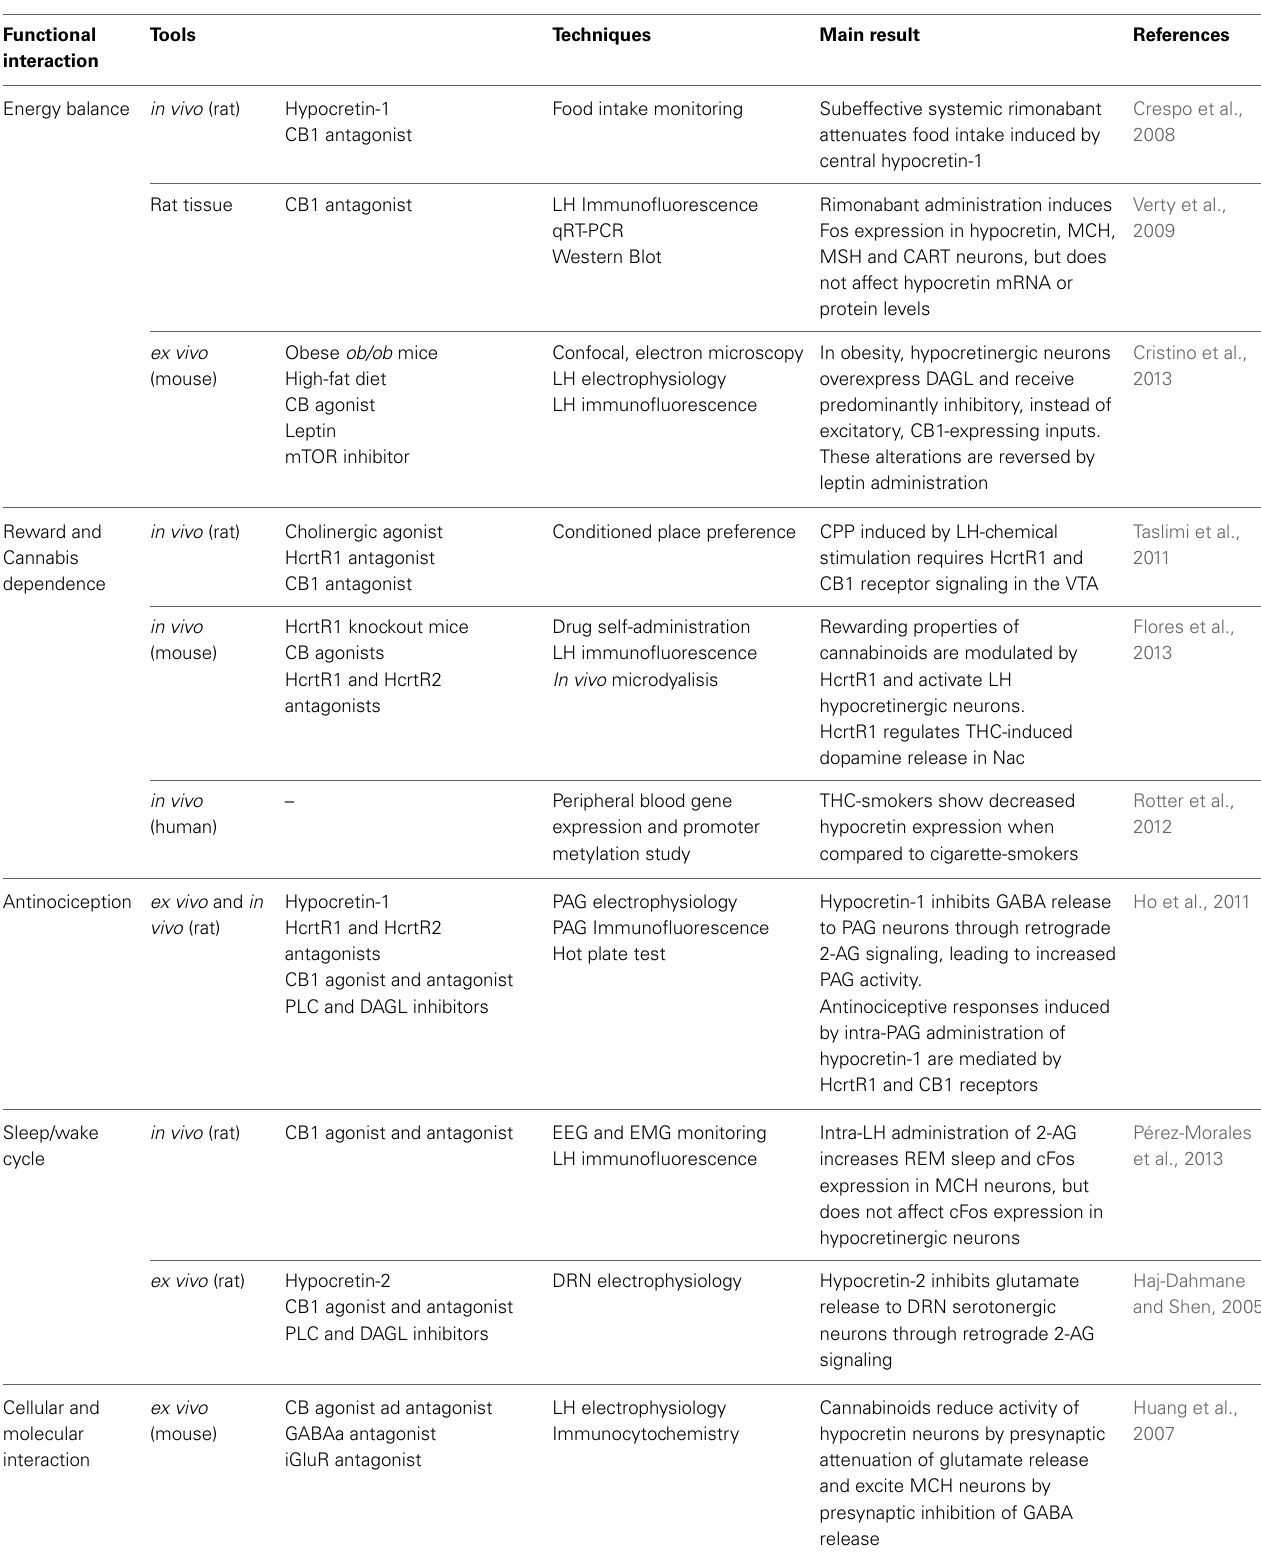
Table 1 | Studies investigating the interaction between endocannabinoid and hypocretinergic systems.